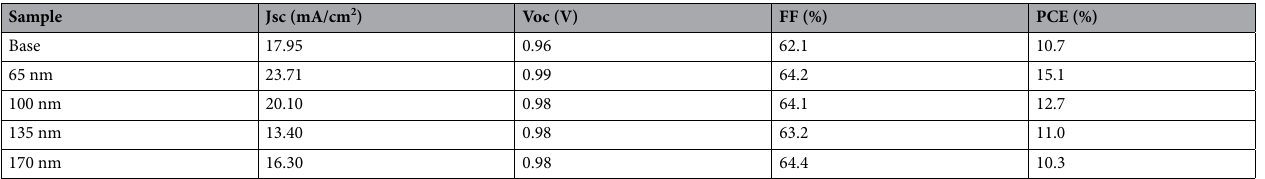
Table 1. Photovoltaic performance parameters summarized J–V measurements with different PPL